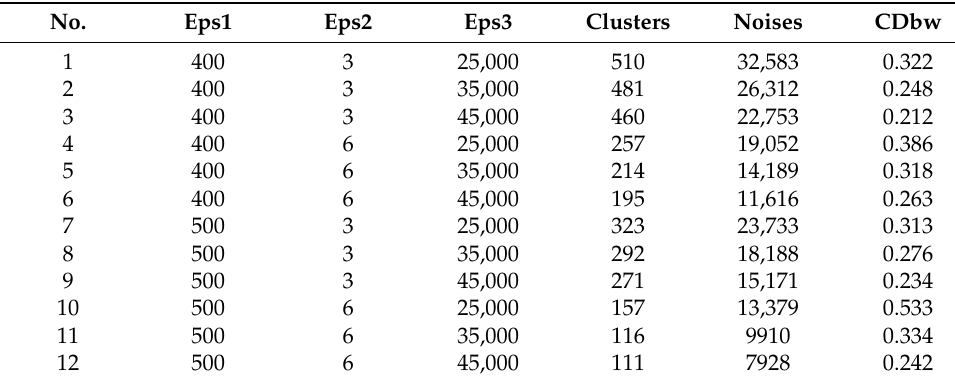
Table 3. CDbw index change with varying parameters.